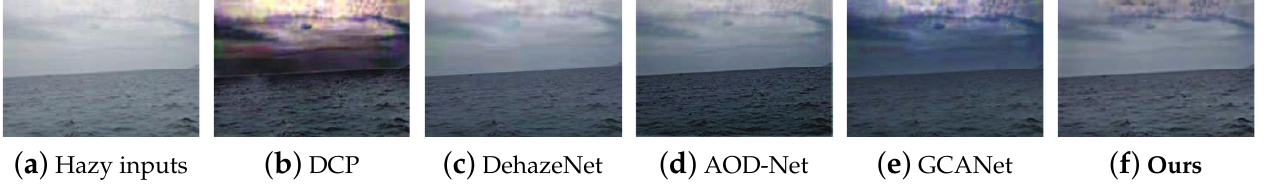
Figure 10. Comparison of dehazing image effects of different networks in real sea–skyline Fig. 10. Comparison of dehazing image effects of different networks in real sea-sky-line detection.